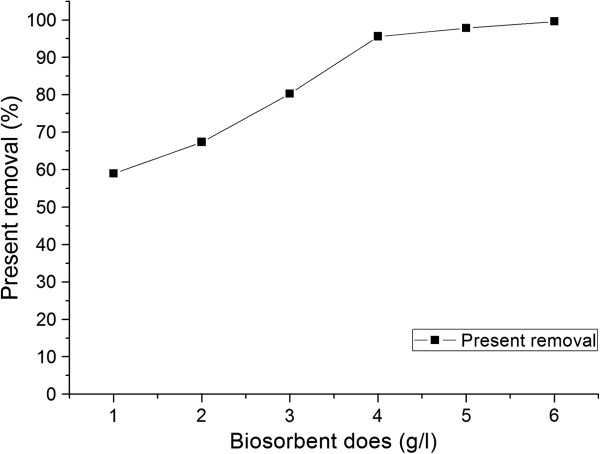
Effect of biosorbent dose on the MG biosorption.